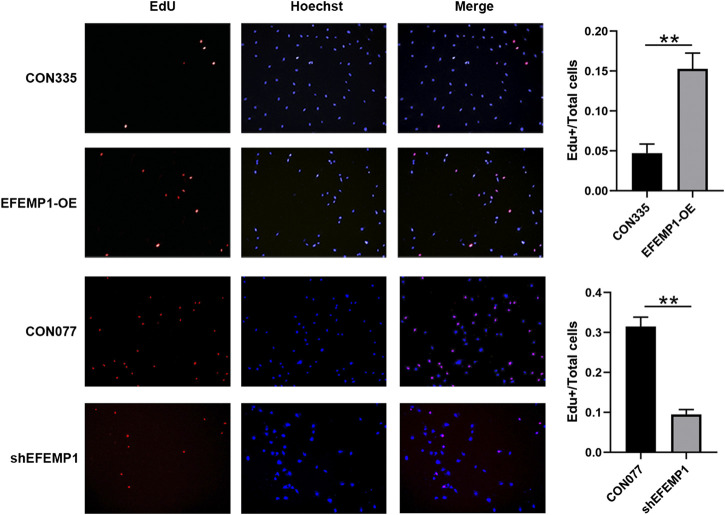
Effects of EFEMP1 on HUVEC proliferation. CON335 HUVECs, EFEMP1-OE HUVECs, CON077 HUVECs, and shEFEMP1 HUVECs were stained using EdU and Hoechst. EdU-positive cells were highlighted in red and nuclei in blue, following Hoechst staining. Proliferation capacities were analyzed by calculating the percentage of EdU-positive cells. Three independent experiments were performed, and five fields were randomly selected for statistical analysis in each experiment. **p < 0.01.